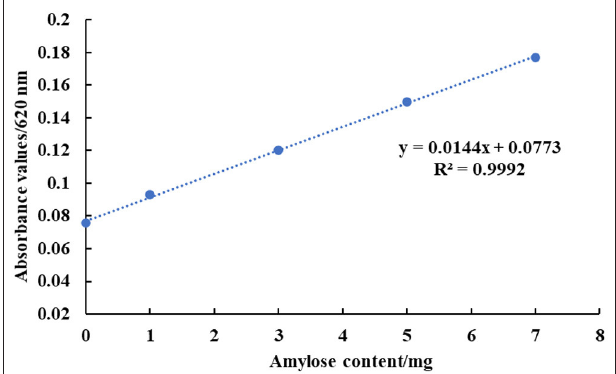
FIGURE 1 | Standard curve of amylose.